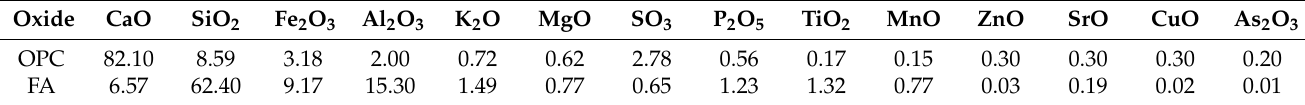
Table 1. Chemical composition of the OPC and FA